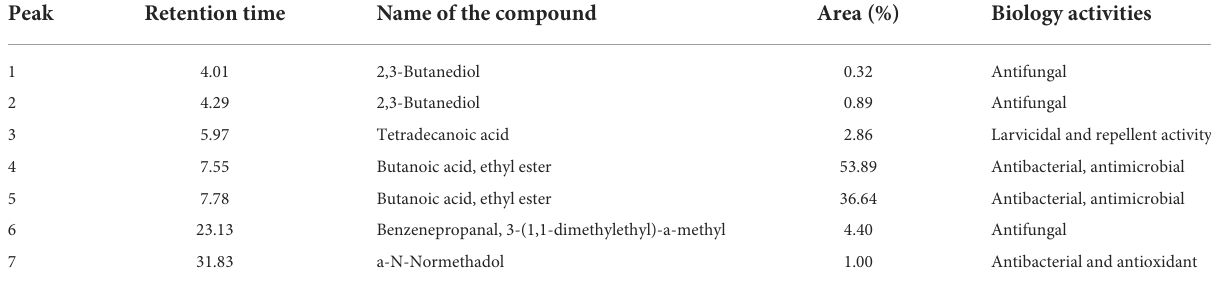
TABLE 6 Compounds of GC-MS analysis of fermented P. caninum with B. agri .